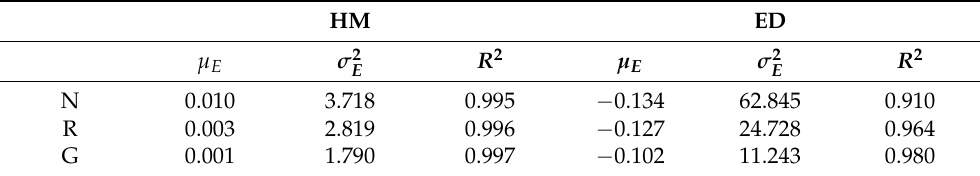
Table 5. Error characteristics of NRG self-validation tests with ( α , λ ) = ( 1600,12 ) , reported for com- parison with Table 4; mean of intensity differences, variance of intensity differences, and coefficient of determination.